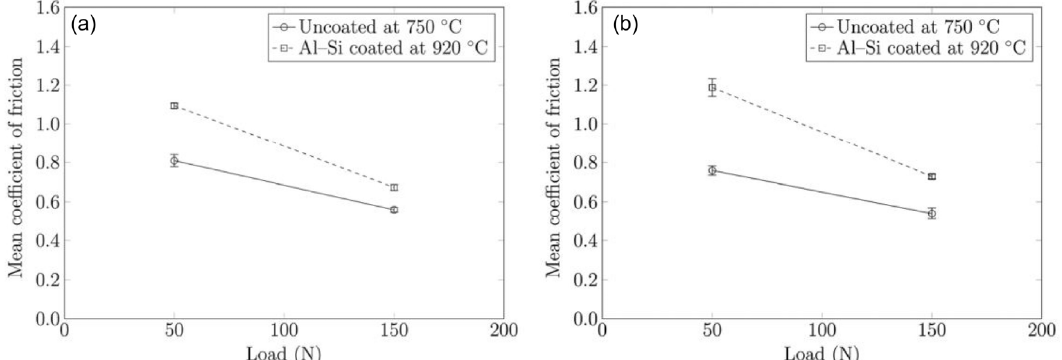
Fig. 23 Mean coef fi cient of friction as a function of normal load for (a) 0.01 m/s sliding velocity and (b) 0.1 m/s sliding velocity. Reproduced with permission from Ref. [537]. © The American Society of Mechanical Engineering,